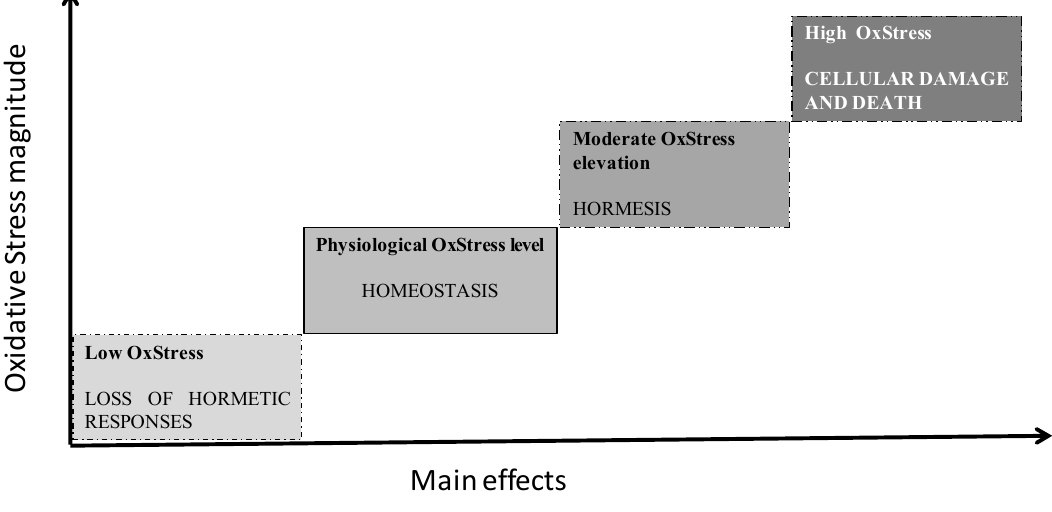
Figure 2. Oxidative stress magnitude and corresponding main